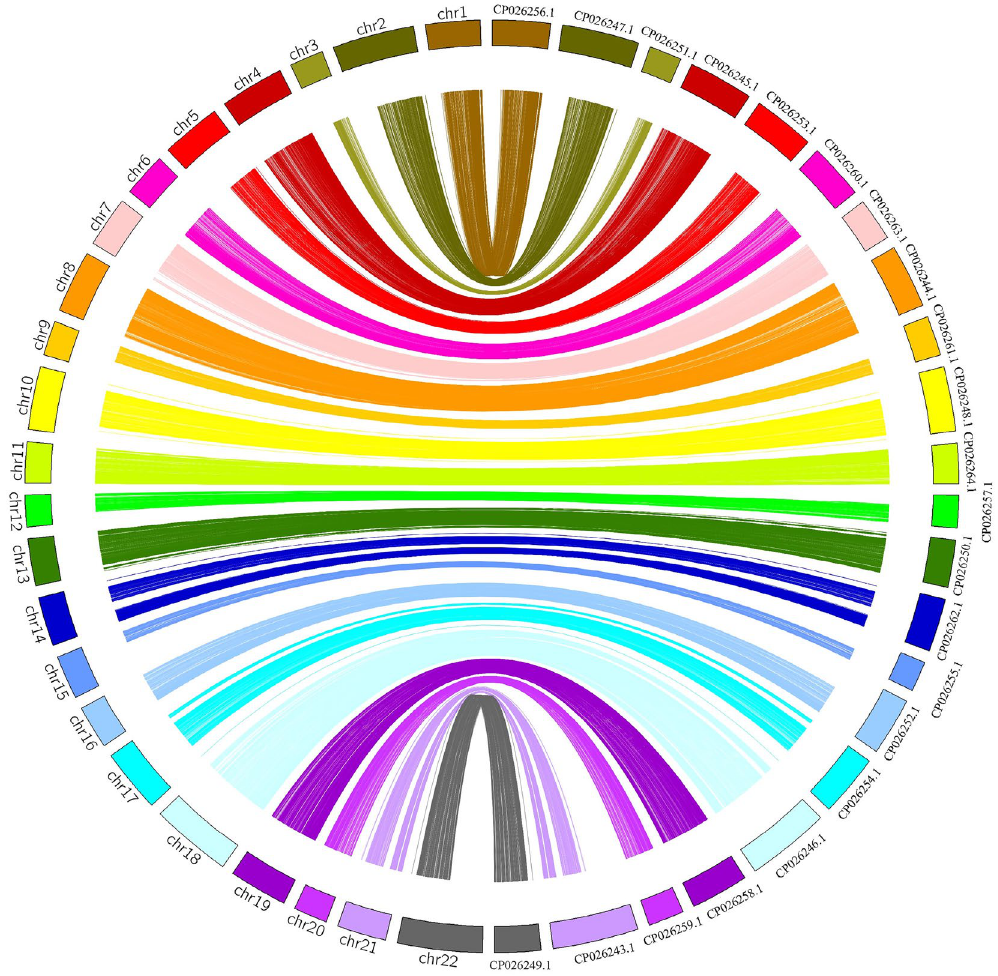
Figure 3. Comparison analysis of the syntenic relationship between the re-anchored genome, and Maroso’s et al. genome (ASM318616v1).